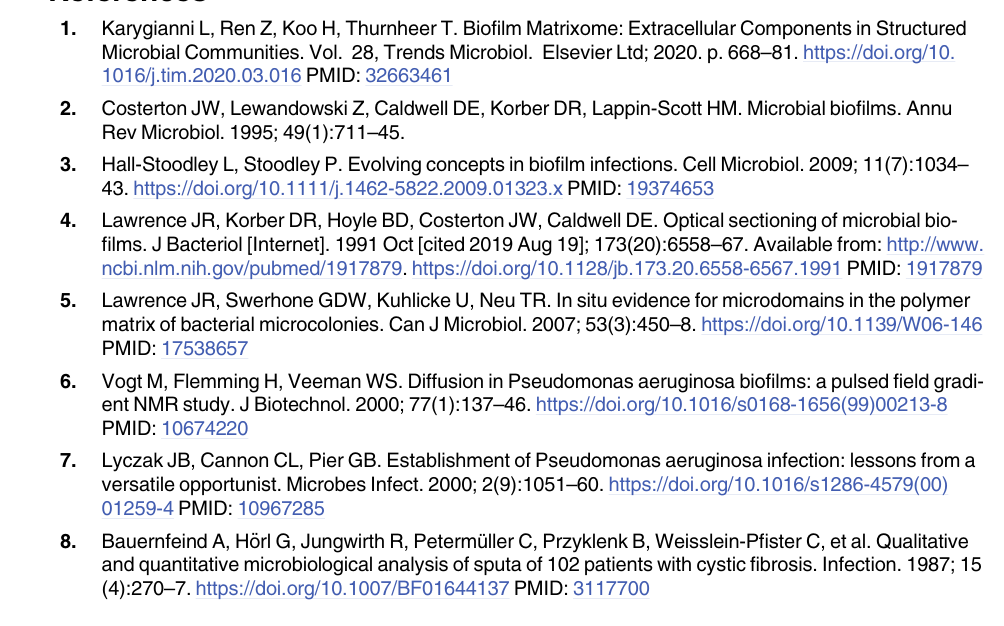
S5 Table. Bond populations and lengths for the Mg 2+ -oxygen contacts in the magnesium 2-chain